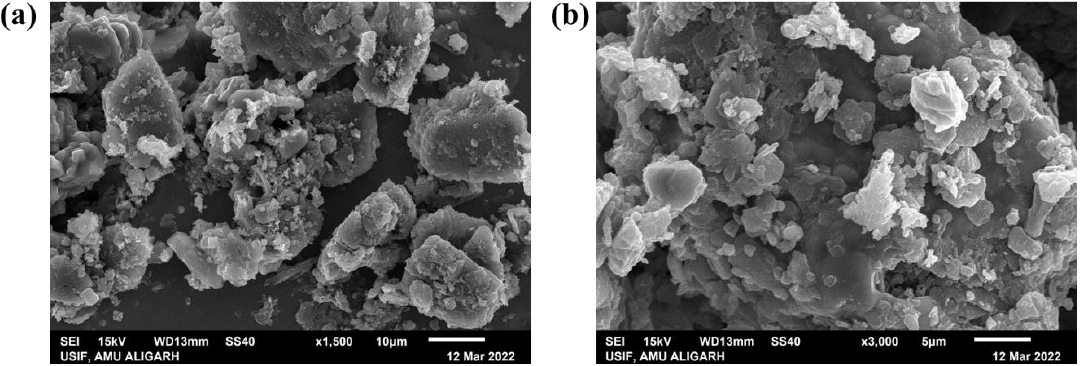
Figure 10. SEM images of ( a ) GO-NCD- 1 and ( b ) GO-NCD- 2 with DNA.